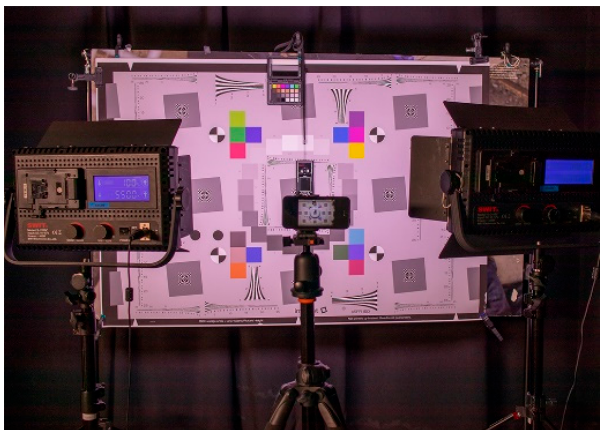
Figure 2. The test chart setup. Two on colour temperature adjustable LED lights are used for a homogeneous illumination. The intensity and the evenness of light uniformity were controlled on a digital light meter.